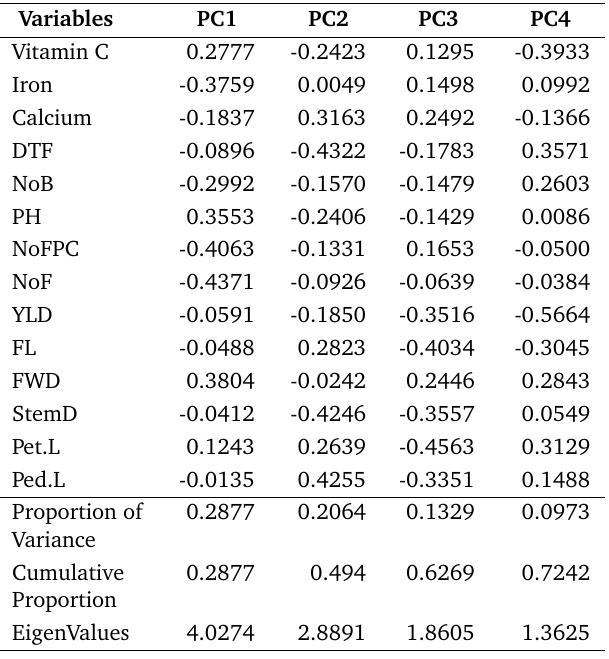
Table 4. Eigenvalues and the proportion of accounted variance for each trait across 20 accessions of eggplant for the first four principal components (PC). DTF, days to flowering; NoB, number of branches; PH, plant height at maturity; NoFPC, average number of fruits per cluster; NoF, average number of fruits per plant; YLD, average yield per plant; FL, fruit length; FWD, fruit width; StemD, stem diameter; Pet.L, petiole length; Ped.L, pedicel